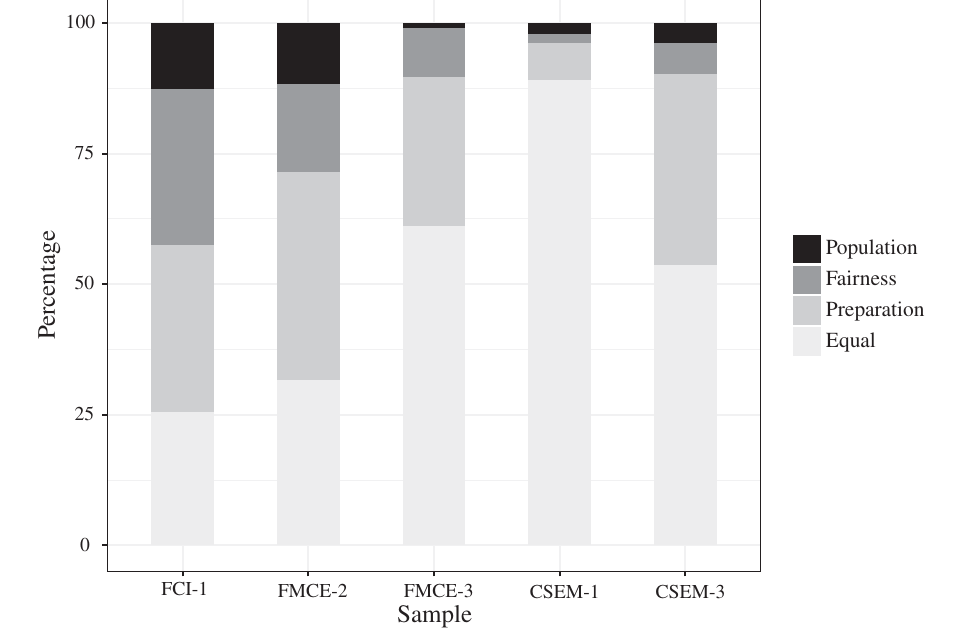
FIG. 3. Relative percentage of each